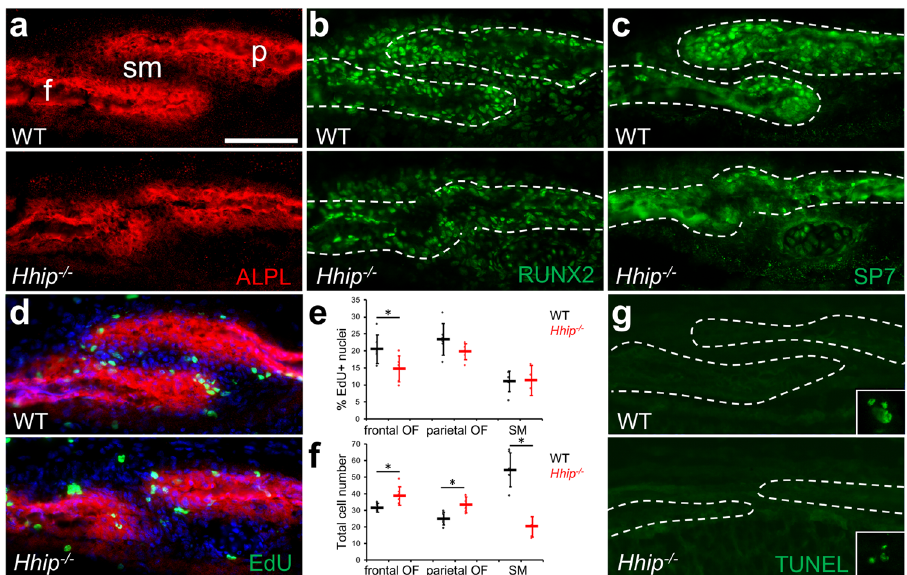
Fig. 6 Coronal suture dysgenesis in Hhip − / − mice at E18.5. a Staining for alkaline phosphatase activity (ALPL, red) in preosteoblasts and osteoblasts for WT and Hhip − / − coronal sutures. f, frontal bone; p, parietal bone; sm, suture mesenchyme. b Immunohistochemistry for RUNX2 (green). Sections are the same as shown in a . c Immunohistochemistry for SP7 (green). d Proliferation detected by EdU incorporation (green). Sections are counterstained for ALPL activity (red) and DAPI (blue). e Quanti fi cation of EdU incorporation in osteogenic fronts (OF) and suture mesenchyme (SM). WT and Hhip − / − are indicated in black and red, respectively. Asterisk indicates a signi fi cant difference using the two-tailed Student ’ s t -test ( P = 0.030). n = 6 WT and six Hhip − / − . f Quanti fi cation of cell numbers per section in OFs and SM. Asterisk indicates a signi fi cant difference using the two-tailed Student ’ s t -test ( P = 0.018, 0.008, and 0.00004, respectively). n = 6 WT and six Hhip − / − . g TUNEL assay for apoptotic cells. Inset, example of an apoptotic cell in non-sutural tissue on the same slide. White dashed outlines, frontal and parietal bones. Data in e and f are presented as dot plots showing mean±standard deviation. Results presented in a , b , c , and g are representative of n = 3 WT and three Hhip − / − independent samples. Sections are in the transverse plane. Scale bar, 100 μ m. Source data are provided as a Source Data fi